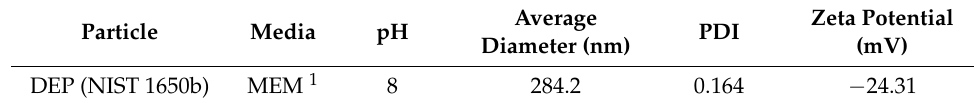
Table 1. Characteristics of the prepared fine particles.